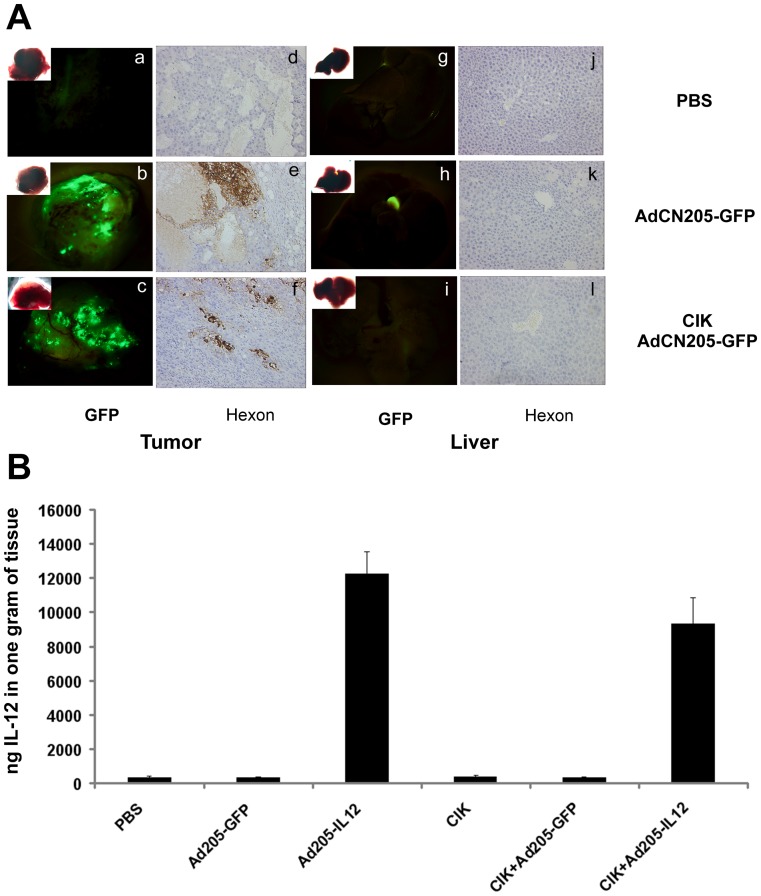
The expression of exogenous gene in tumor sections and liver tissues.(A). Histologic and fluorescence analysis of tumor and liver sections from mice treated with PBS (a, d, g and j), AdCN205-GFP (b, e, h and k), CIK plus AdCN205-GFP (c, f, i and l). a to c, GFP was observed by fluorescence microscopy in the tumor tissue treated with PBS, AdCN205-GFP, or CIK plus AdCN205-GFP. d to f, Immunohistochemical staining for adenoviral hexon protein on the tumor sections (brown staining). g to i, GFP was observed by fluorescence microscopy in liver tissues. j to l, Immunohistochemical staining for adenoviral hexon protein on the liver sections. Original magnification, 200×. (B). The expression of hIL-12 in tumor fraction. Tumor tissues collected at the day of 6 after treatment. The hIL-12 was detected by ELISA. The data was presented as the mean ± SD (n = 3 per group).